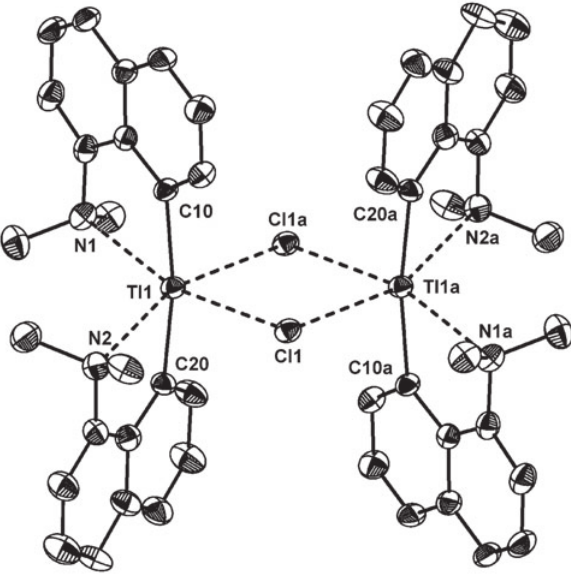
Figure 2 Molecular structure of 2 showing 30 % probability dis- placement ellipsoids and the atom